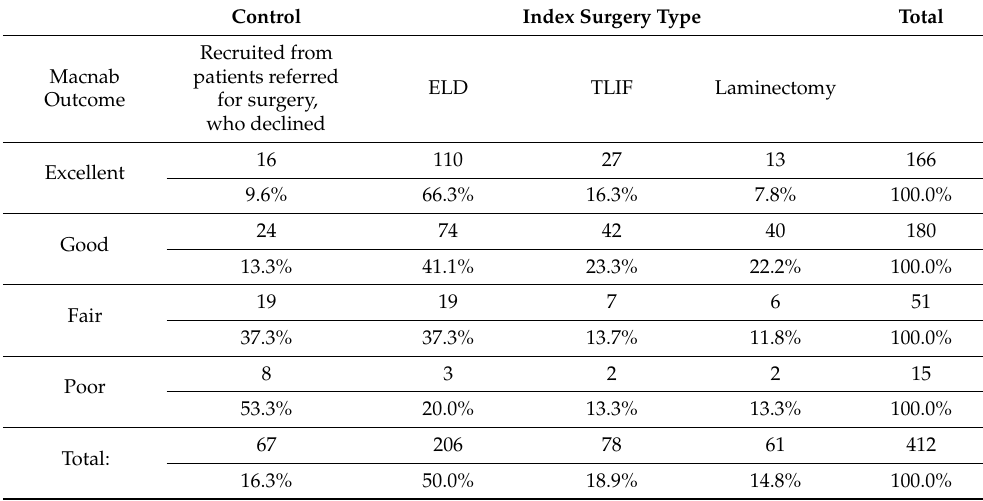
Table 3. Macnab Outcomes with ELD, TLIF, and Laminectomy.